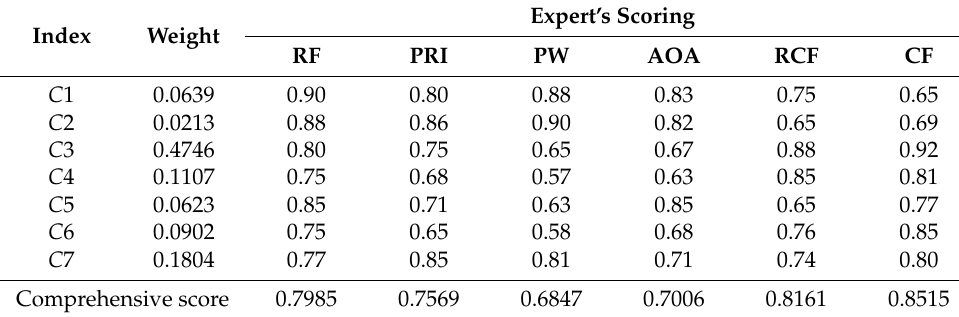
Table 4. The comprehensive results of each feature by